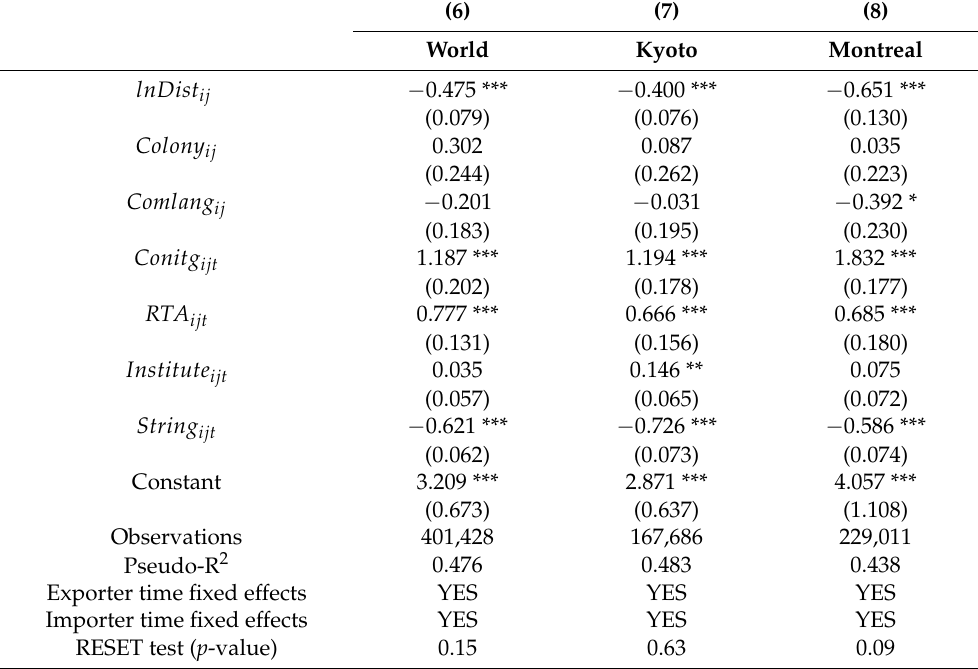
Table 6. PPML HDFE Estimation Results: Kyoto and Montreal